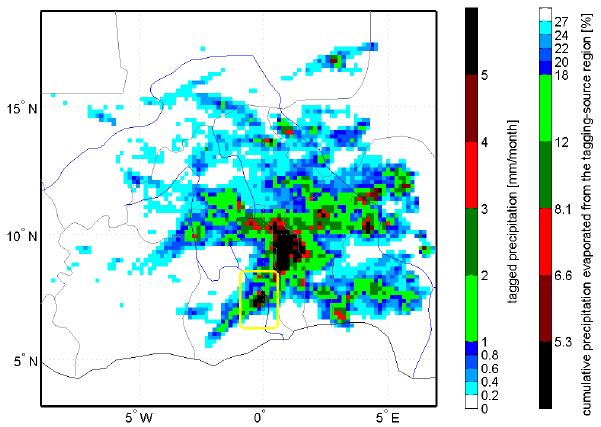
Fig. 7. Precipitation of Volta origin in August 1998 as computed by 3D-T-E_lowmixing. See Fig. 3 for an explanation of the colours.